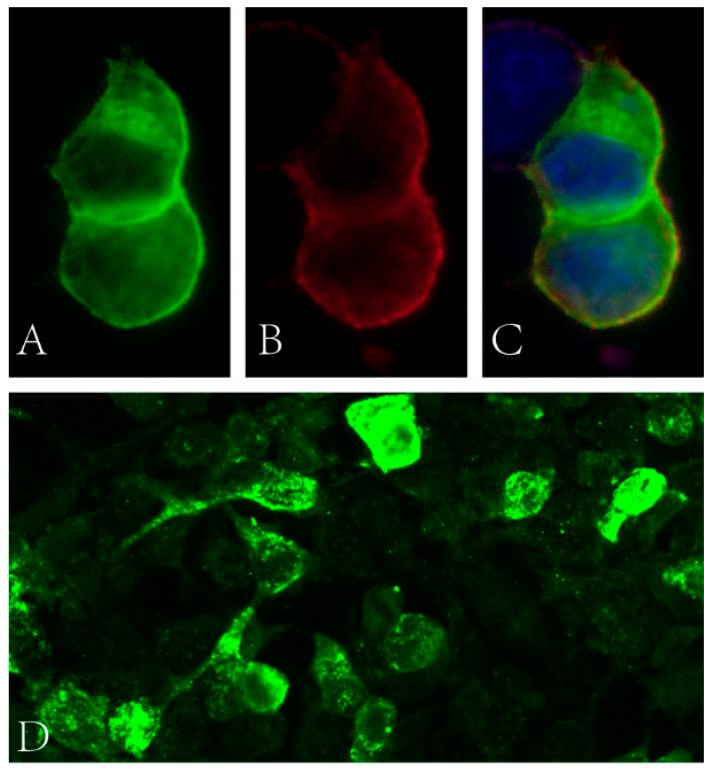
Figure 1. ( A – C ) Binding of patient’s serum to HEK cells transfected with NF186 (green fluorescence: NF186 protein; red fluorescence: human IgG; blue fluorescence: nucleus). ( D ) Binding of patient’s serum to HEK cells transfected with CV2 (green fluorescence: human IgG).